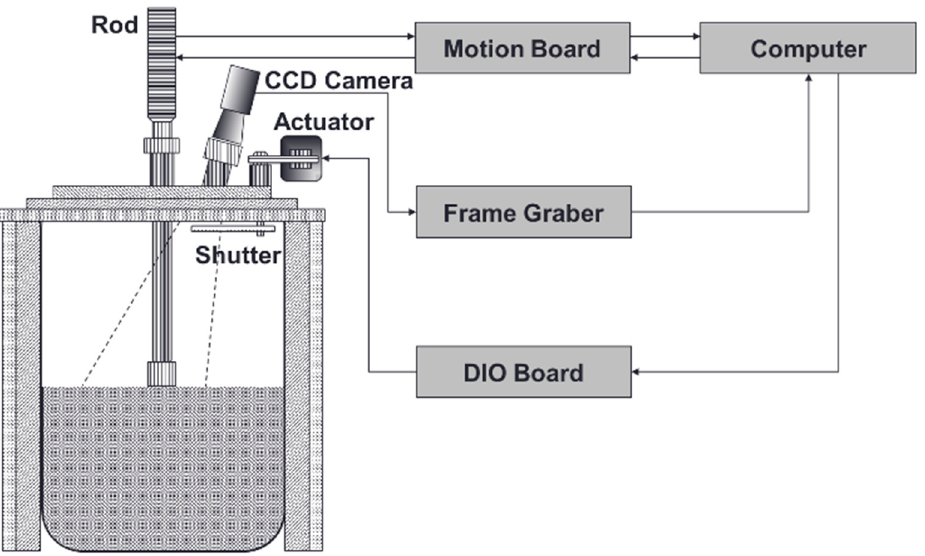
Figure 8. Block diagram of the auto seeding system.